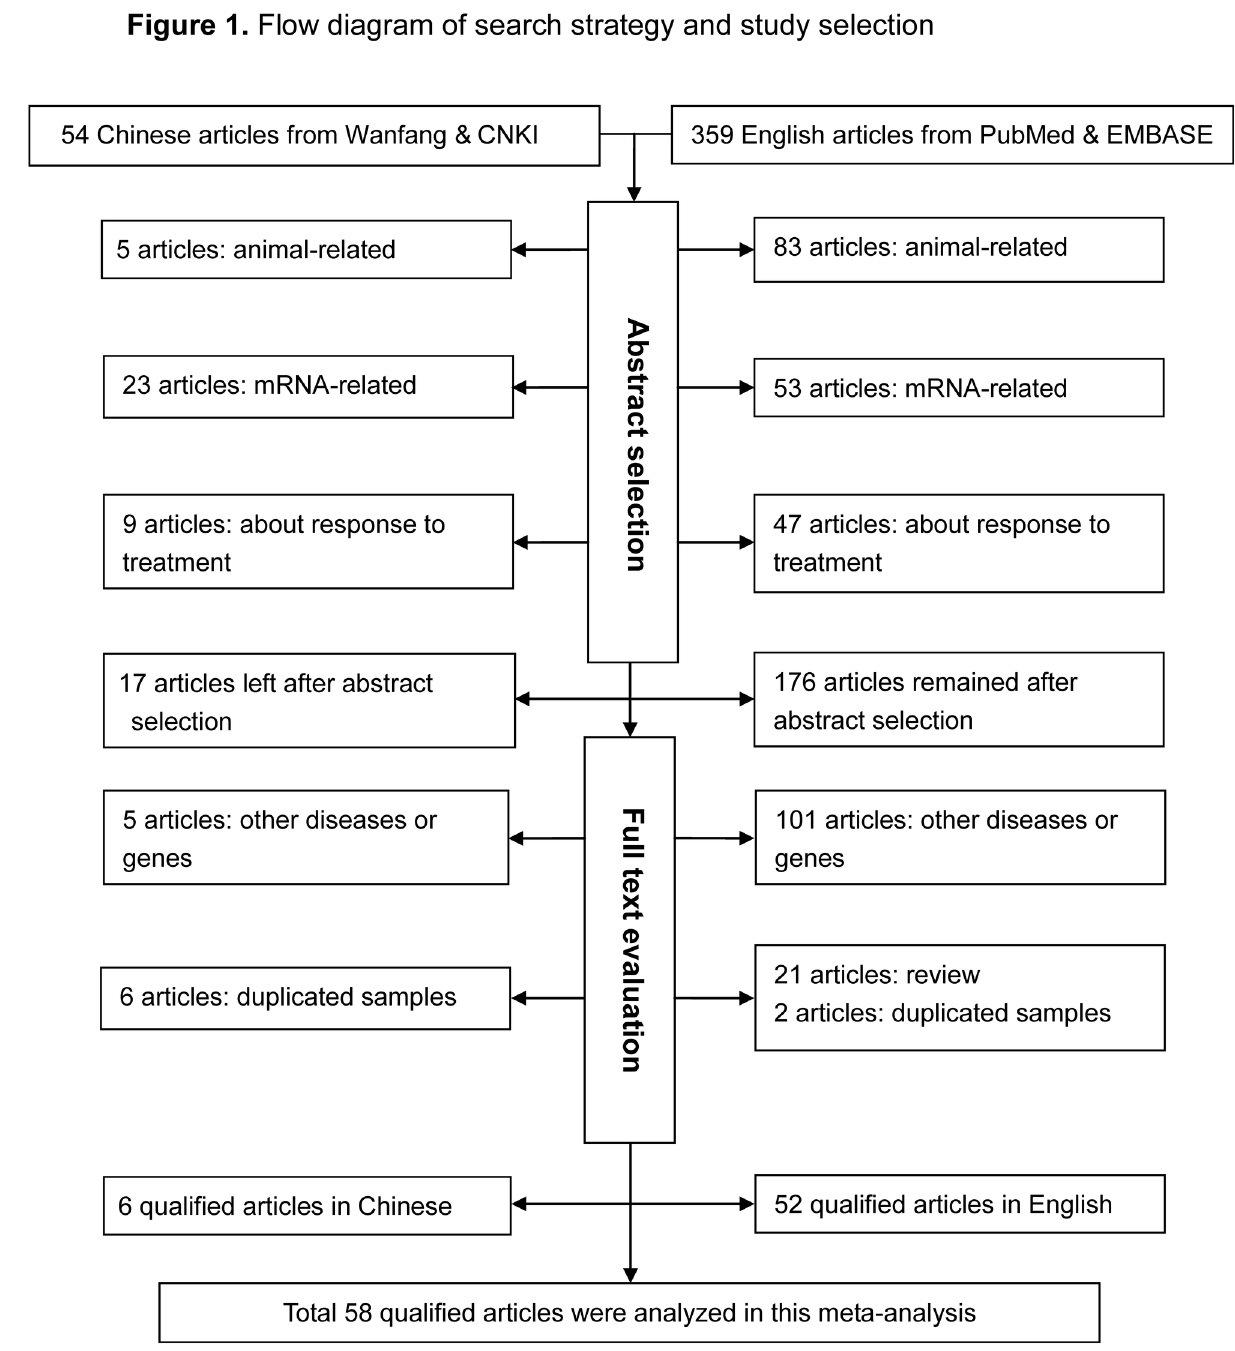
Figure 1. Flow diagram of search strategy and study